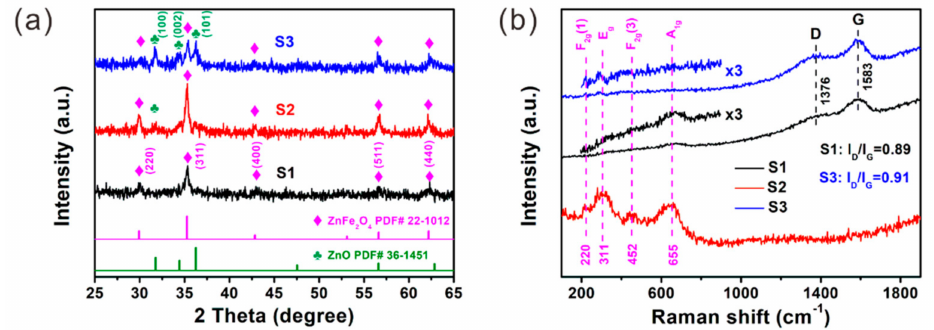
Figure 1. ( a ) XRD patterns and ( b ) Raman spectra of